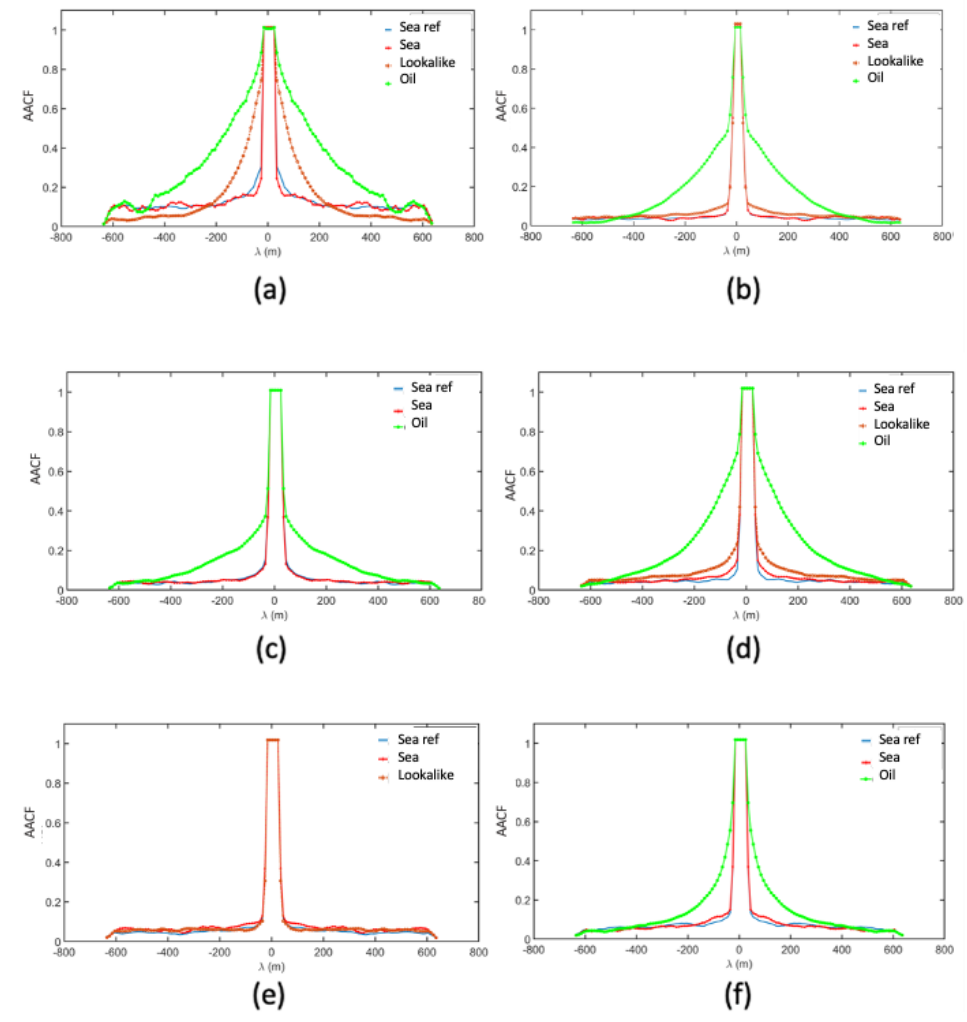
Figure 4. AACFs evaluated over the ROIs highlighted in Figure 2. ( a – f ) refer to the SAR scenes labeled as data ID 1–6 in Table 1. Note that each AACF is normalized to its maximum